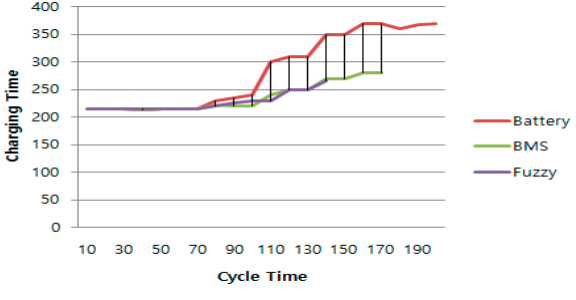
Figure 15. A 50 V charge time comparison per cycle.